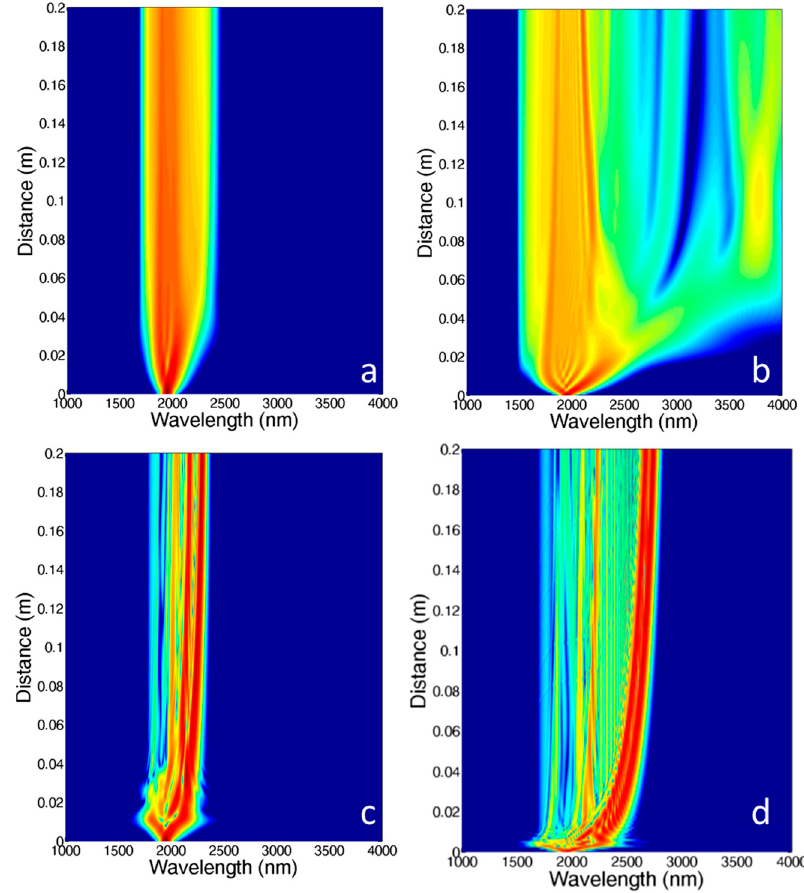
Figure 9. Simulated supercontinuum generation with constant loss at 6 dB/m and with: ( a ) Current design at 20 kW peak power; ( b ) Current design at 100 kW peak power; ( c ) 4 µm-core Air-clad design at 20 kW peak power; ( d ) Air-clad design at 100 kW peak power.